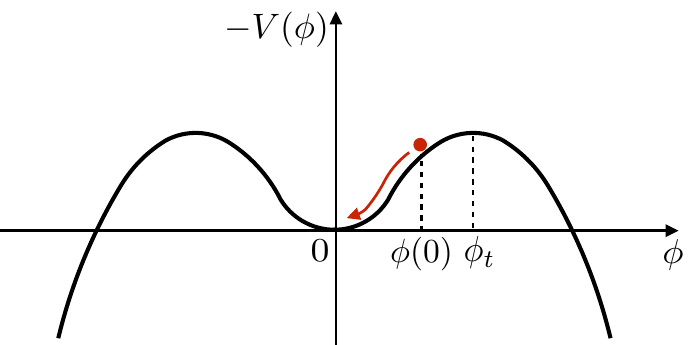
Figure 41. The equation of motion (E.7) can be interpreted as a particle moving in the potential − V ( φ ) with time-dependent friction. We are interested in trajectories that start from rest at ρ = 0 and reach φ = 0 at the time ρ = ρ . Apart from the trivial trajectory φ ( ρ ) = 0 , there may be other ? classical trajectories with lower action. This depends on the potential. However, if such a trajectory exist for some ρ then it will also exist for larger ρ . Indeed, it is sufficient to start with a larger ? ? then there is always another trajectory because φ (0) , and φ (0) → φ t when ρ ? → ∞ . If V 00 (0) < − d 2 4 the late time motion around φ = 0 is oscillatory. This corresponds to the Breitenlohner-Freedman criteria for the instability of the trivial vacuum around φ = 0